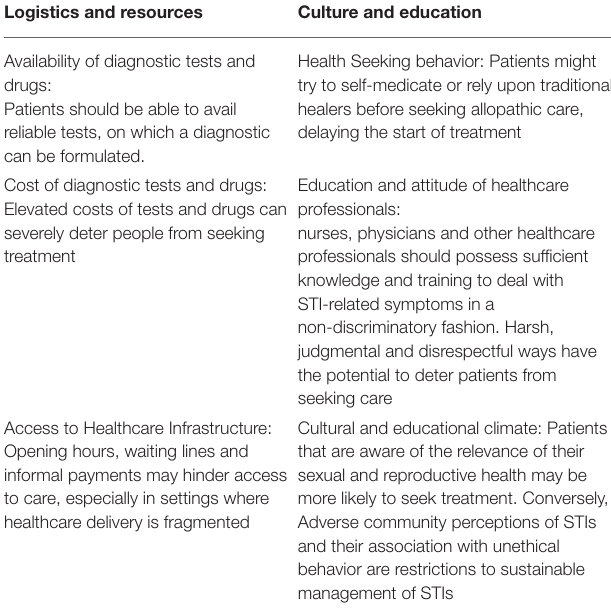
TABLE 2 | Barriers to Chlamydia tracho matis